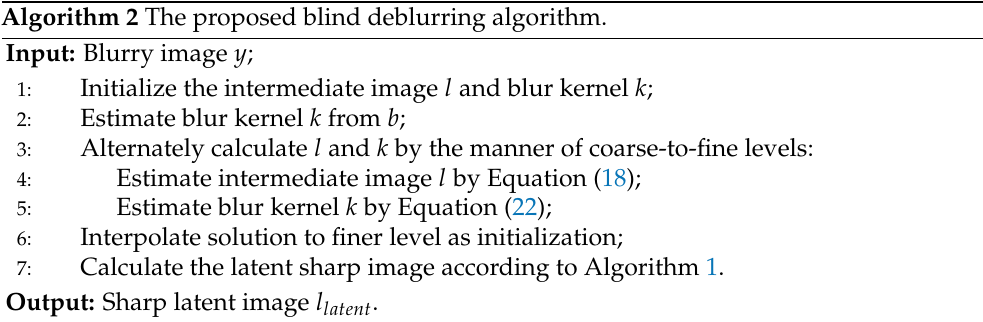
Algorithm 2 The proposed blind deblurring